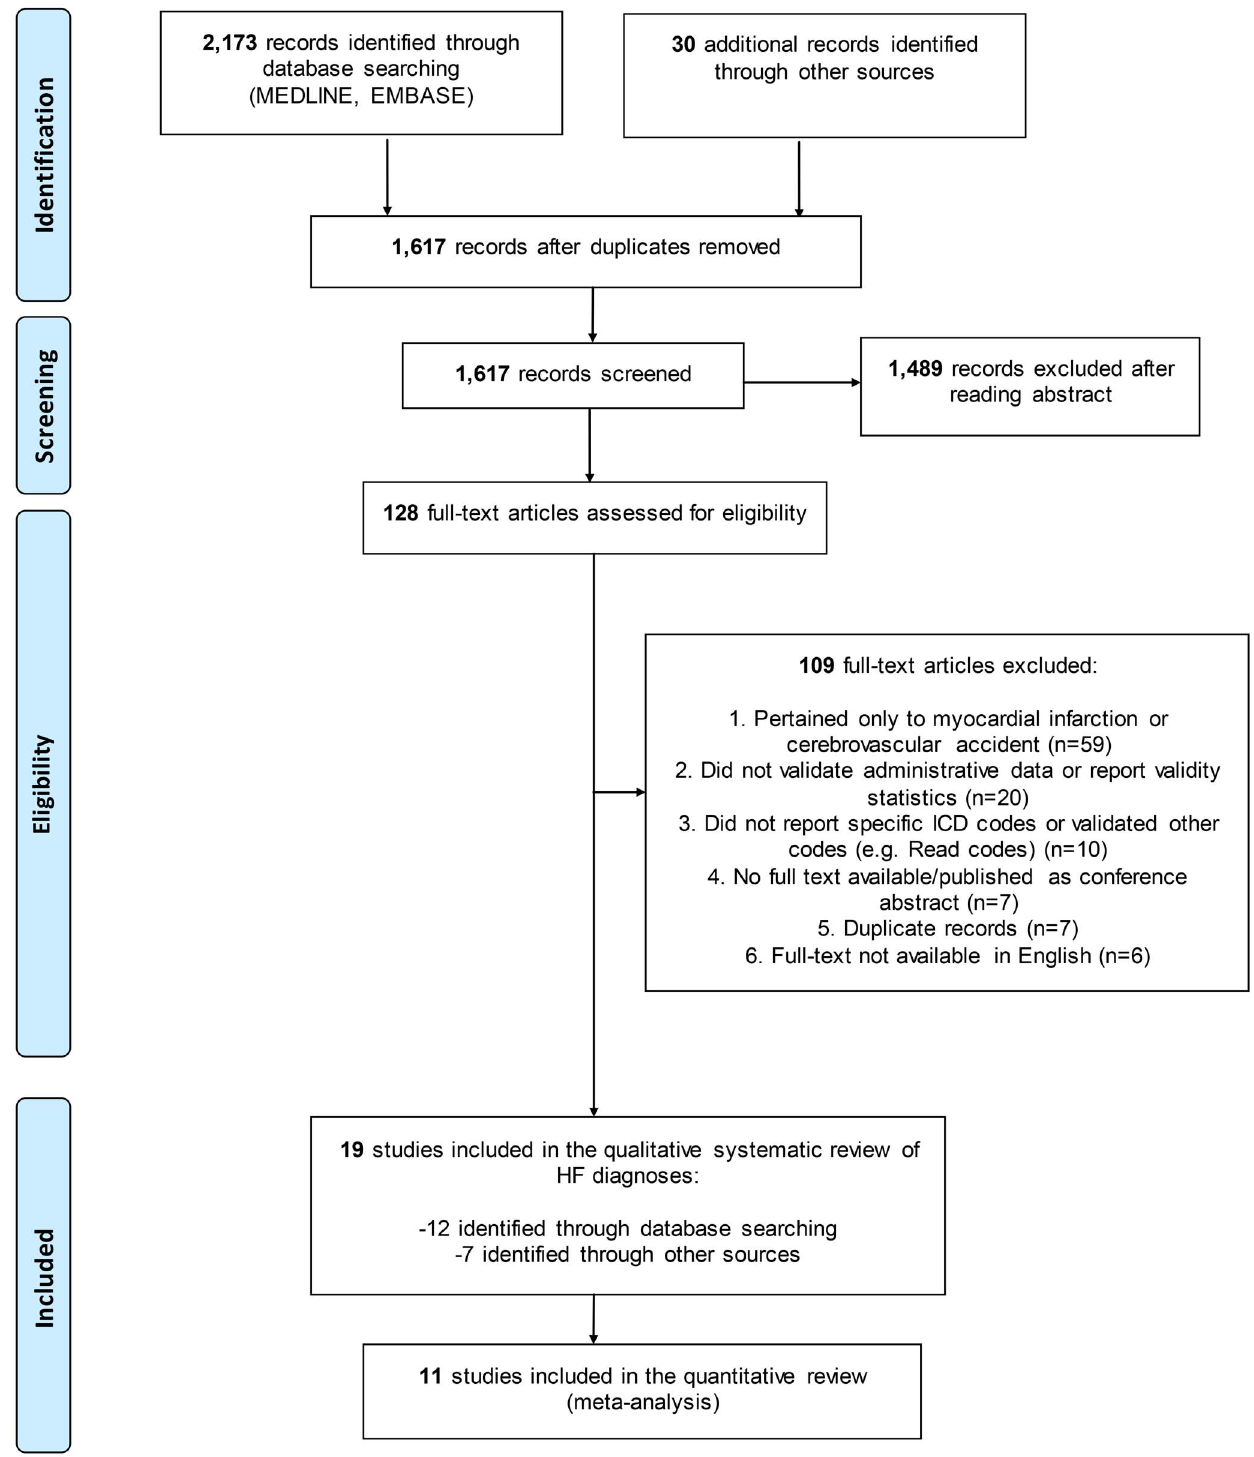
Figure 1. Preferred Reporting Items for Systematic Reviews and Meta-Analyses (PRISMA)-style Flowchart of Study Selection and Review. HF=heart failure; ICD=International Classification of Diseases doi:10.1371/journal.pone.0104519.g001 estimates ranged mainly from 74% to 76%, and the specificities Results of the jackknife sensitivity analysis, wherein the pooled estimates were re-calculated after the removal of one study at a from 96.6% to 96.9%. The two most influential studies were those time, are shown in Table 3 . The resulting pooled sensitivity by Onofrei et al (sensitivity =77.5% and specificity =93.3% after